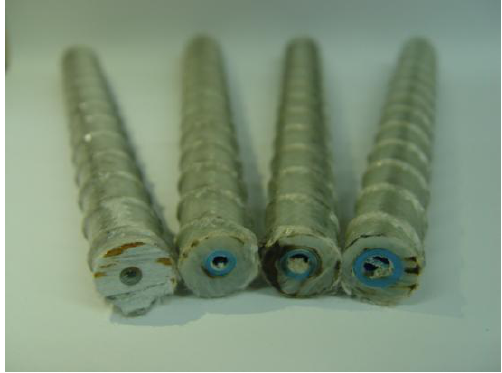
Figure 7. Cross-section of hollow GFRP rebars (D16).